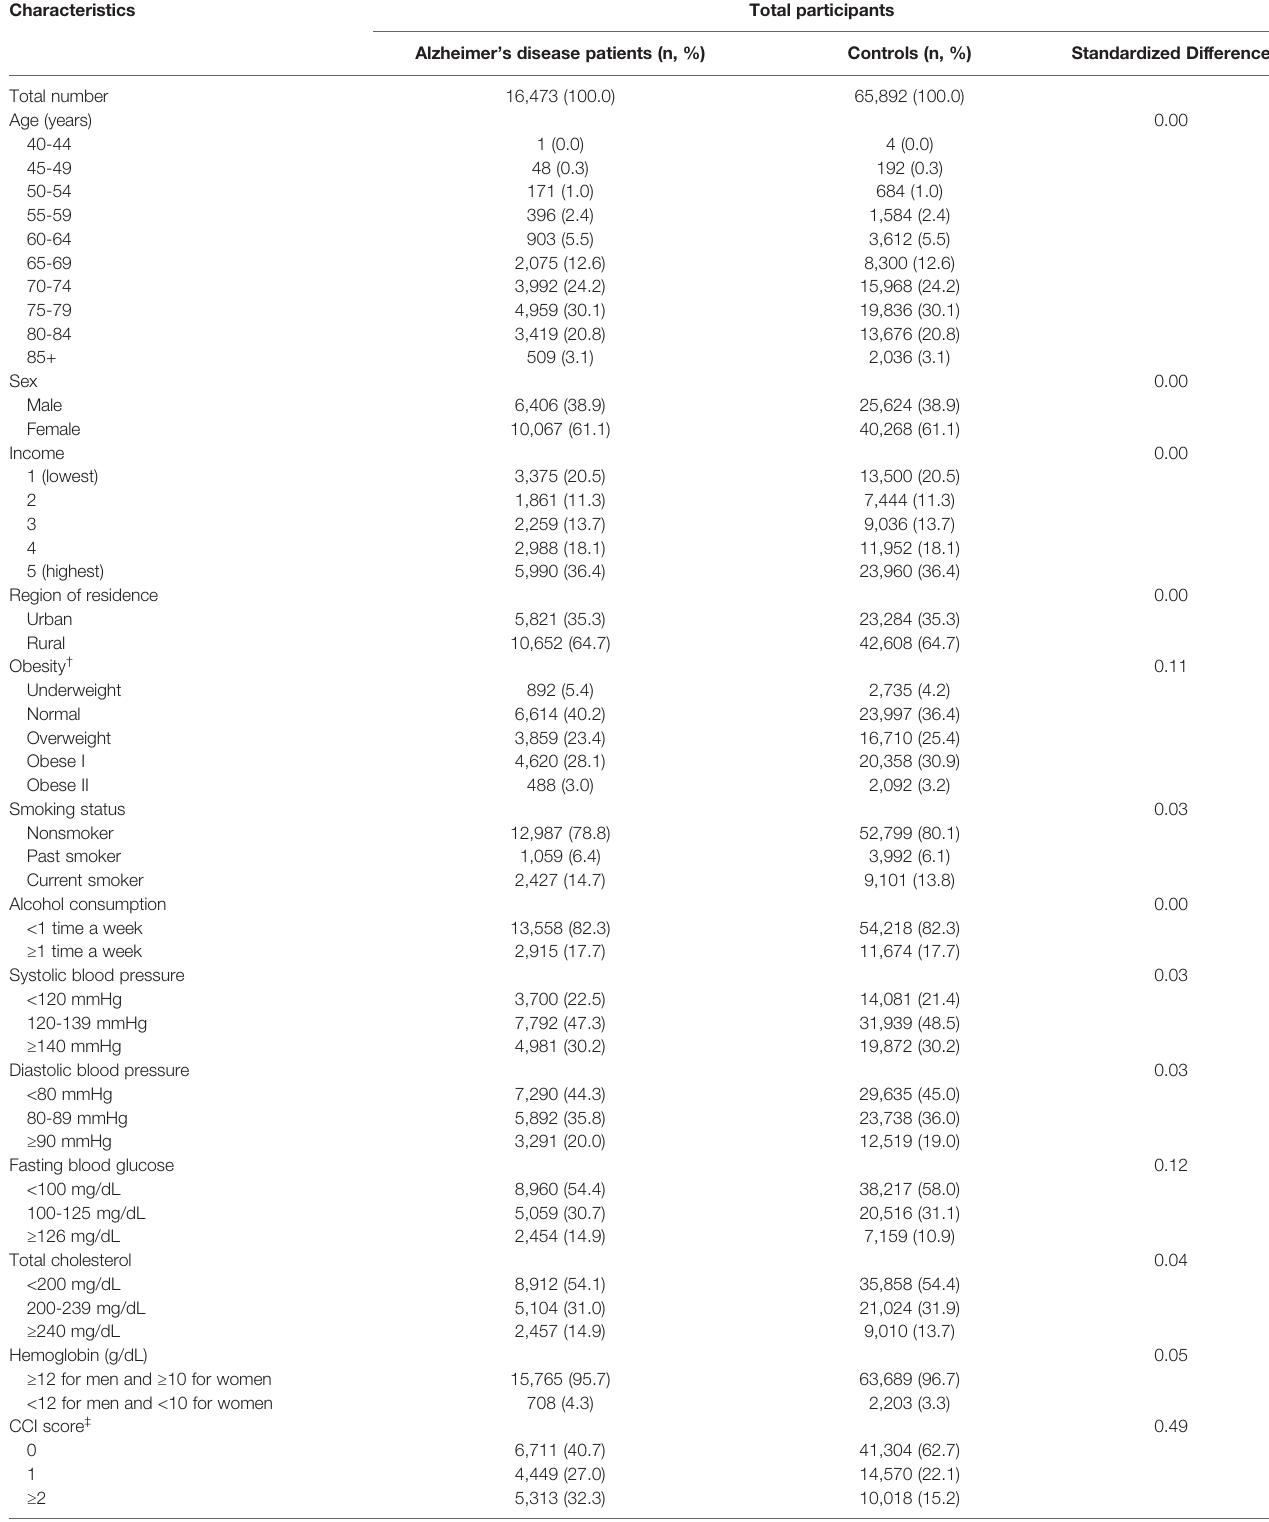
TABLE 1 | Baseline characteristics of the study